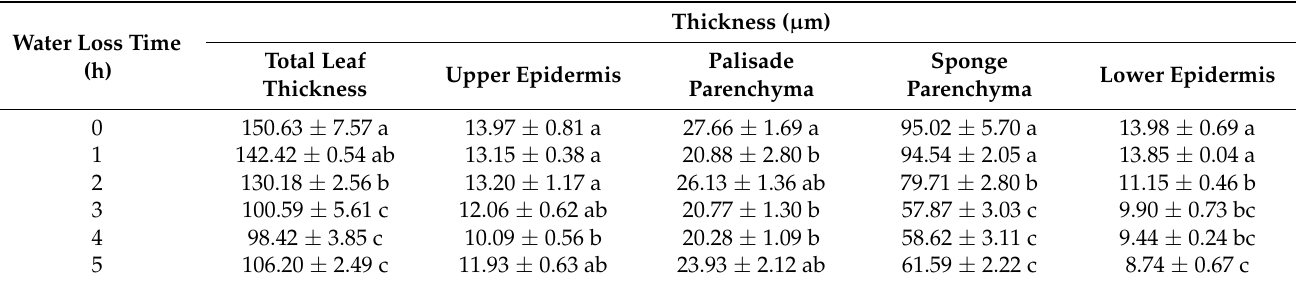
Figure 1. Changes of elastic modulus (Em, N per unit deformation) of O. violaceus ( A ) and B. napus ( B ). (Note: Different letters appear above the error bars of the same plant species when subsequent values differ significantly at p ≤ 0.05, according to one-way ANOVA). Table 2. Leaf anatomical parameters of O. violaceus .